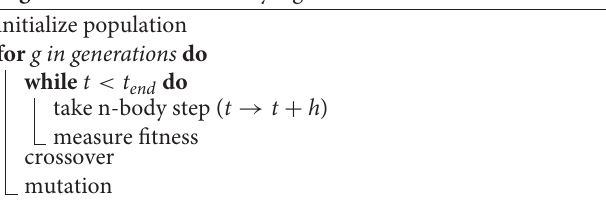
Algorithm 1 Genetic n-body